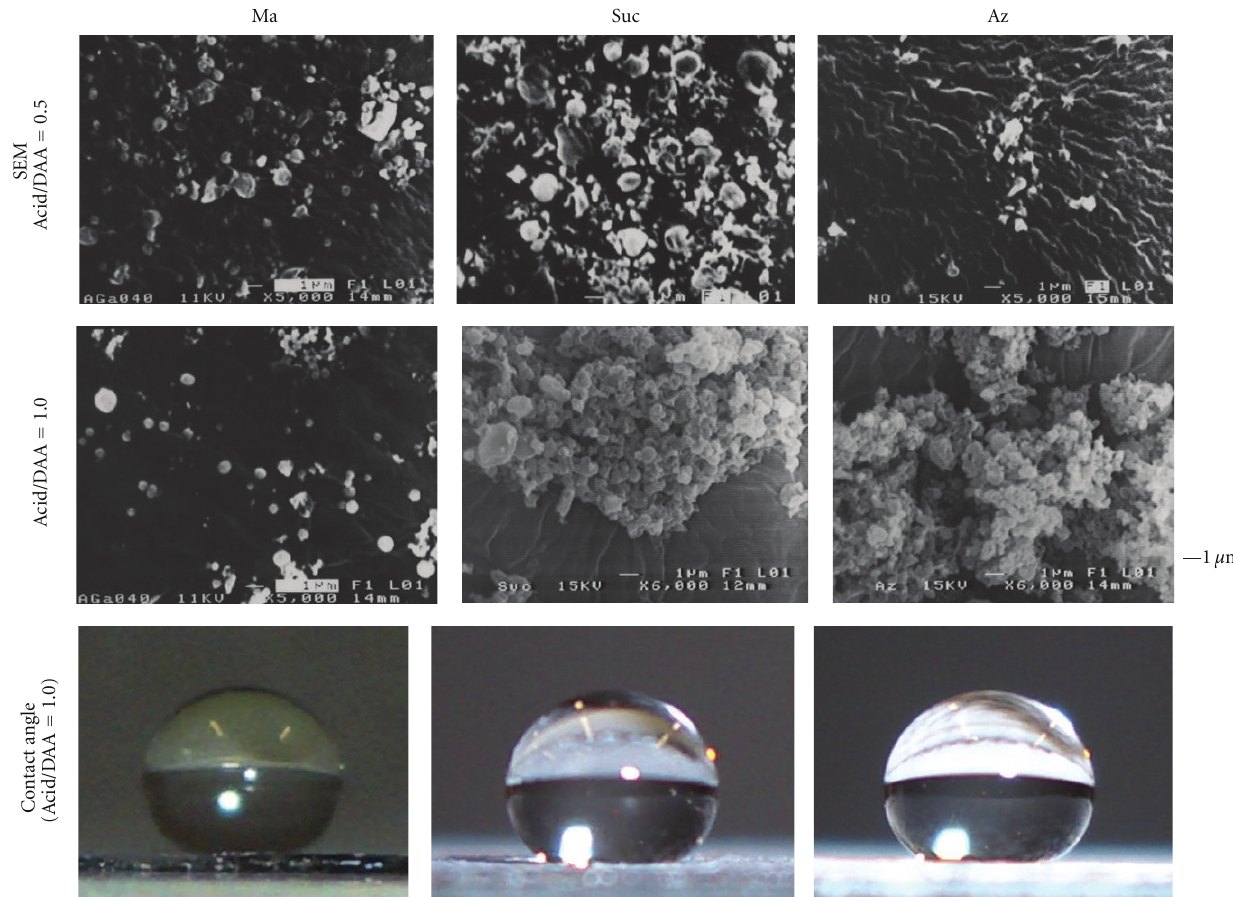
Figure 18: SEM images of the particles produced by the copolymer in the presence of Ma, Suc, and Az, and photographs of water droplets placed on the surface coated with the